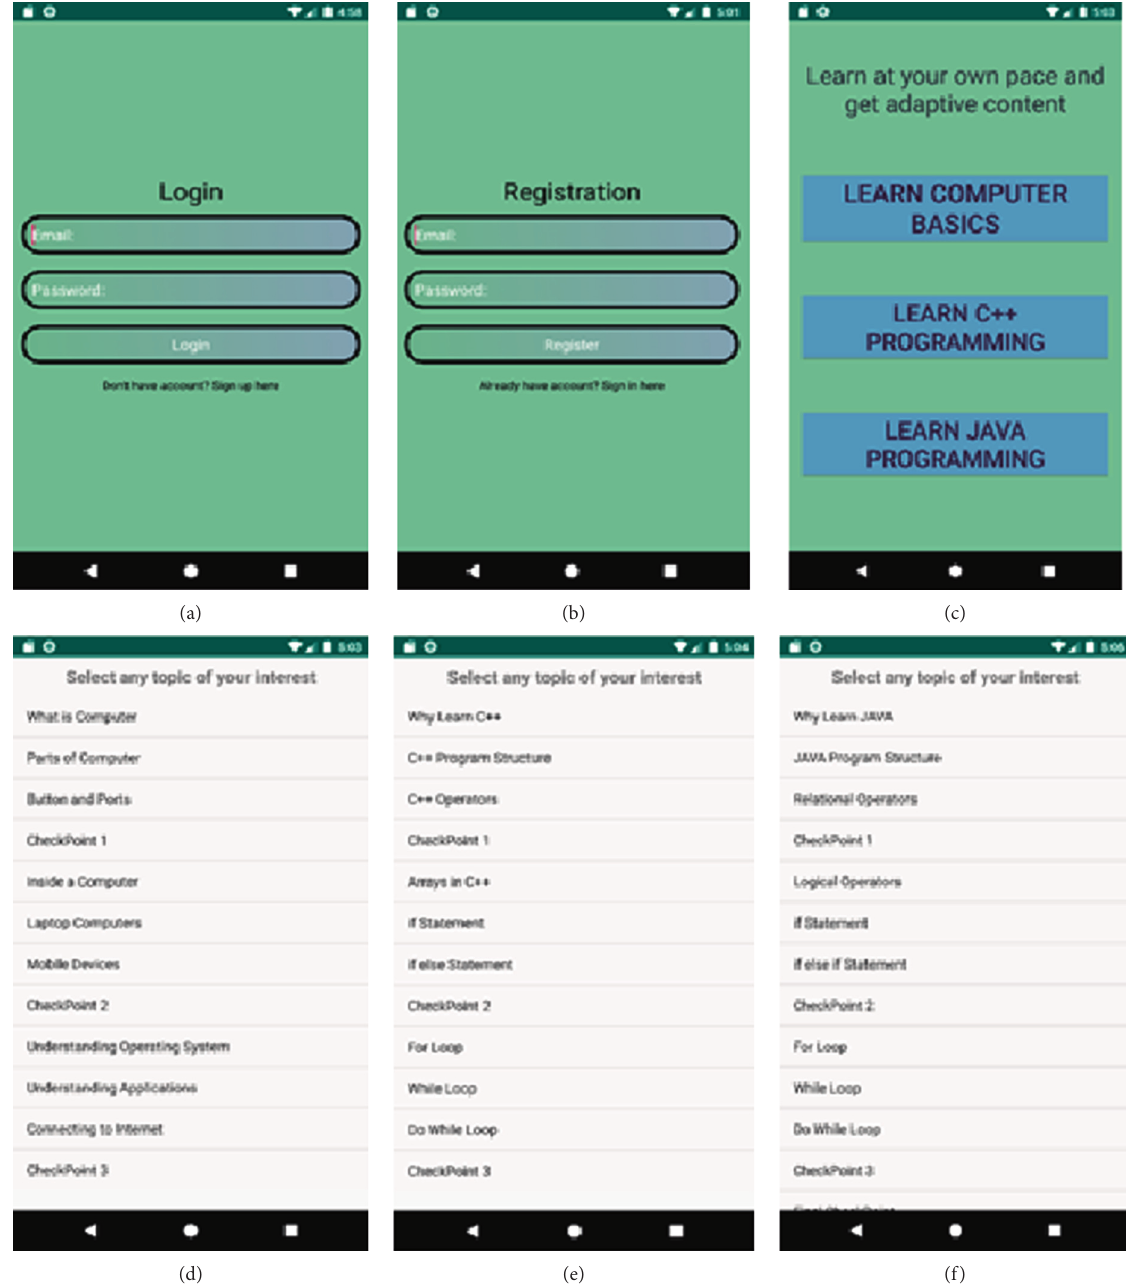
Figure 2: Learner interaction with the Learnit app. (a) Learner login activity. (b) Learner registration activity. (c) Course selection activity. (d) Computer basics topics. (e) C++ topics. (f) JAVA